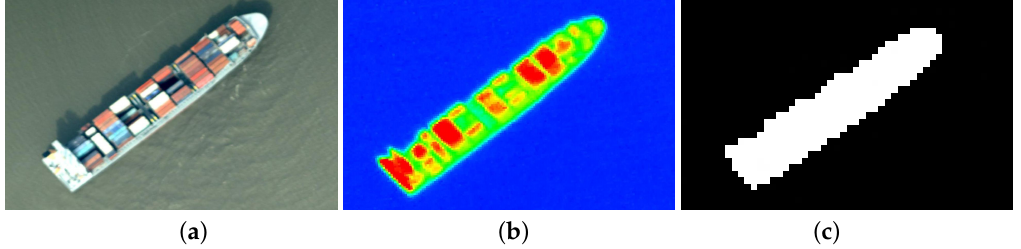
Figure 10. Example of quicklook images of potential ship objects.